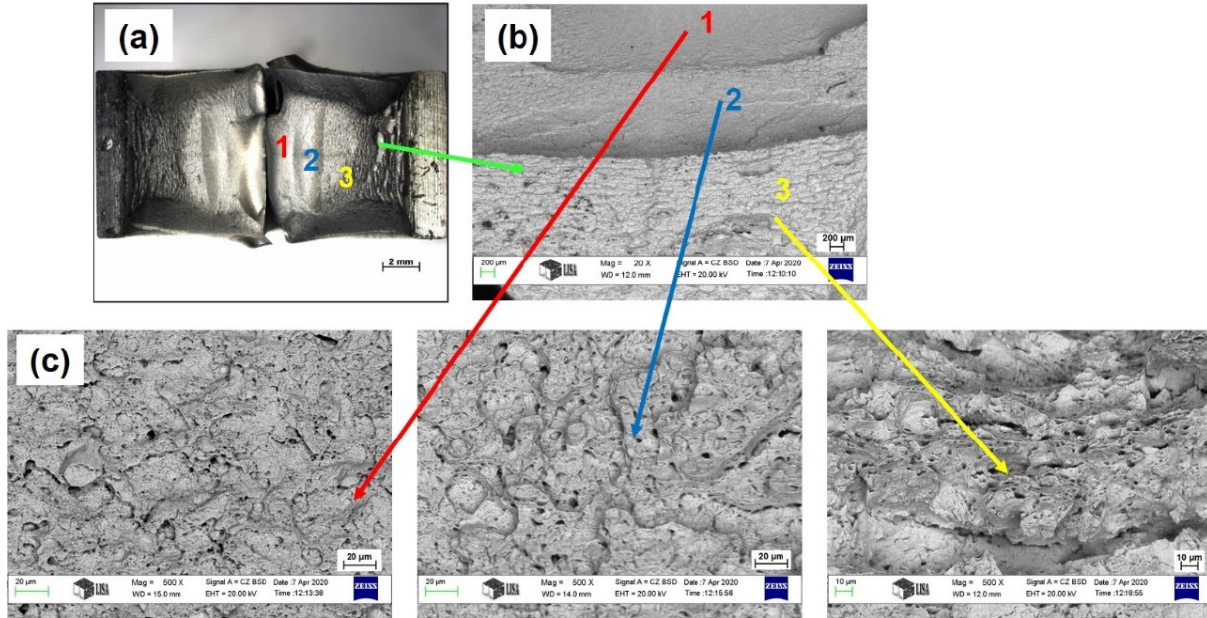
Figure 11. ( a ). BM Charpy V specimen at a test temperature of − 40 °C; ( b ) SEM photo of full-fractured surface having three zones; ( c ) fractographs of three zones.